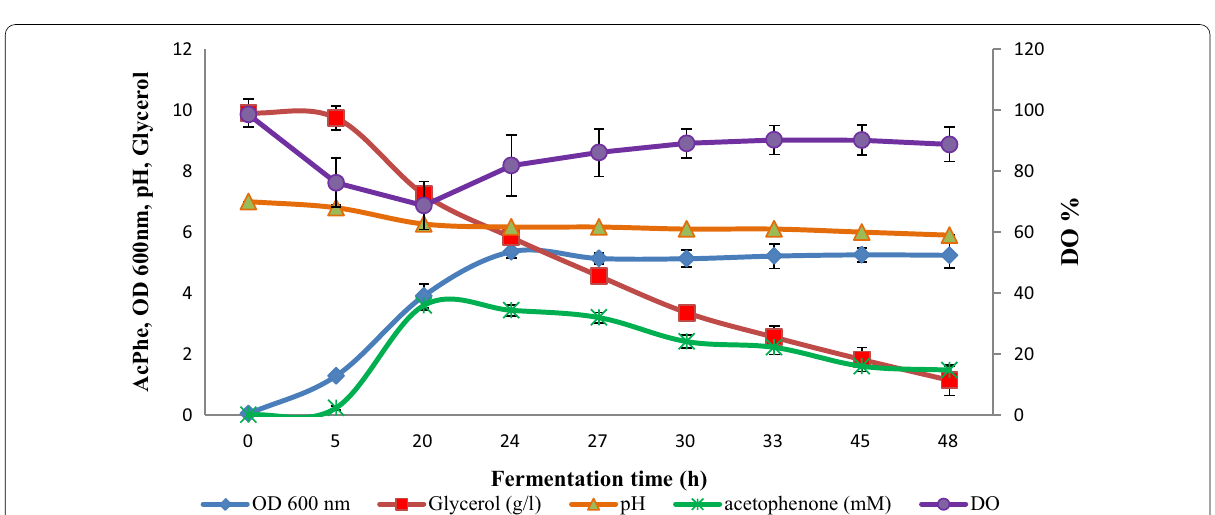
Fig. 4 Fermentation process in batch culture of Bacillus sp. strain BaH in Sixfors bioreactor. Error bars represented standard